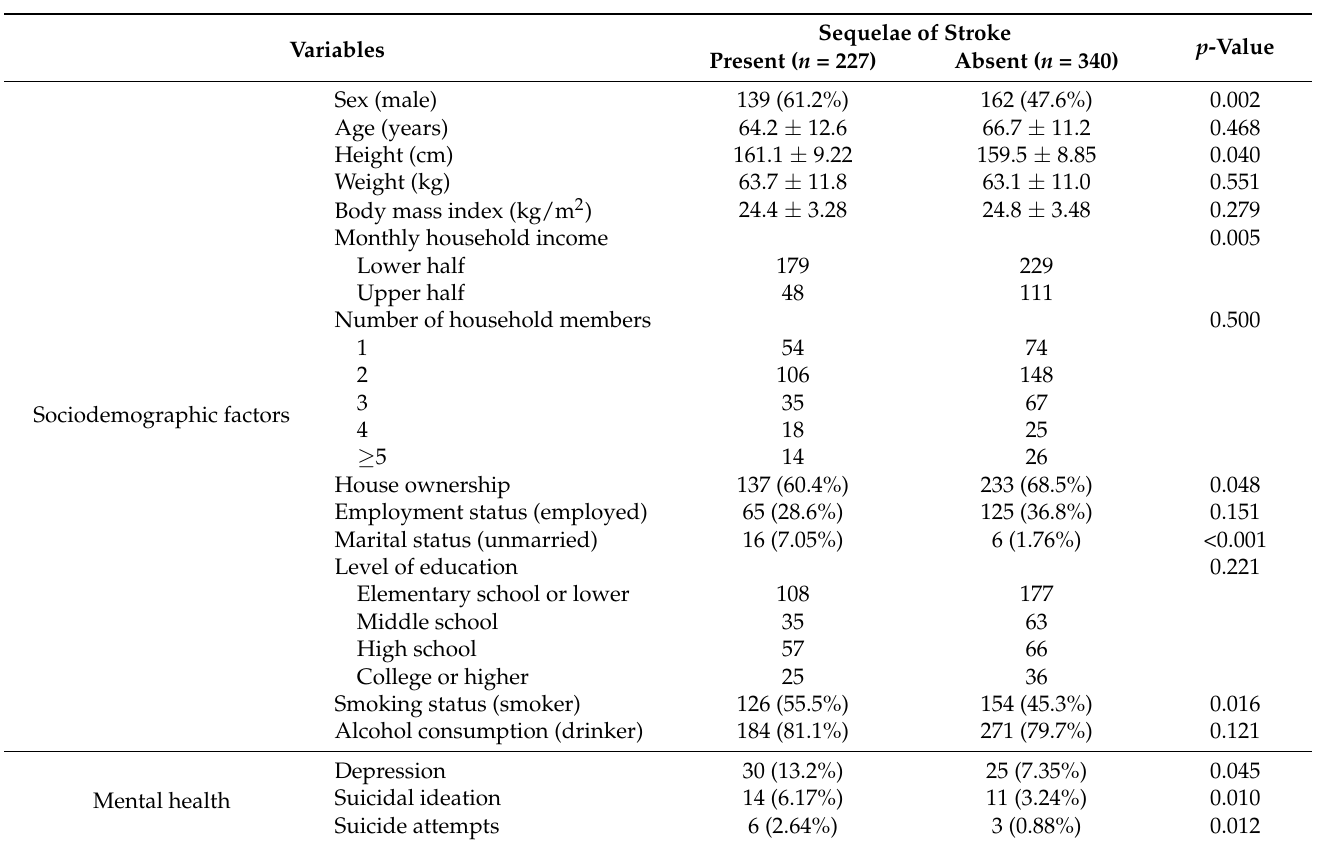
Table 2. A comparison of stroke patients with and without sequelae retrieved from the Korea National Health and Nutrition Examination Survey (KNHANES)